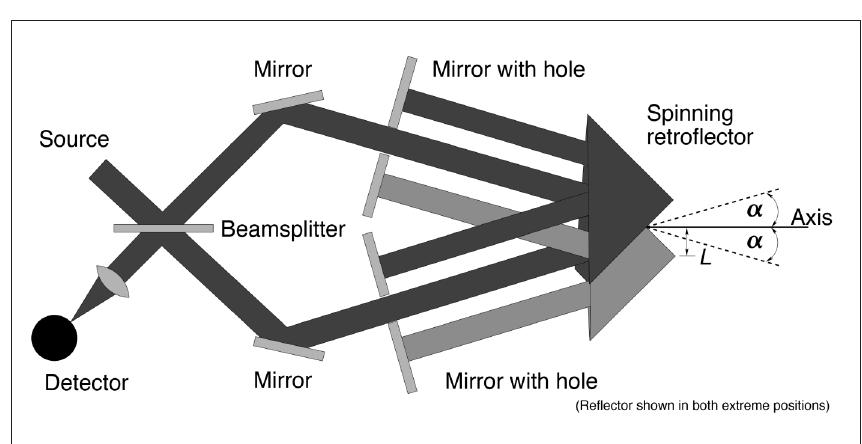
Fig. 1. Optical set-up of the MIROR Fourier transform